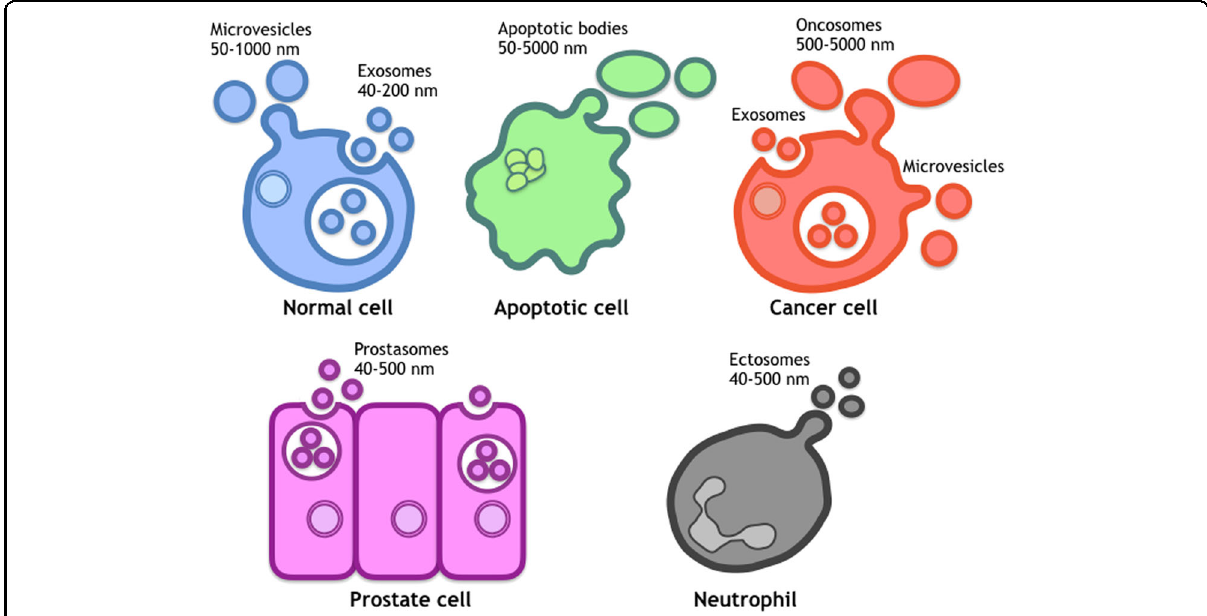
Fig. 1 Various types of extracellular vesicles (EVs). Several EVs are released from cells. The sizes cannot properly de fi ne each EV, and current knowledge is not suf fi cient to accurately classify